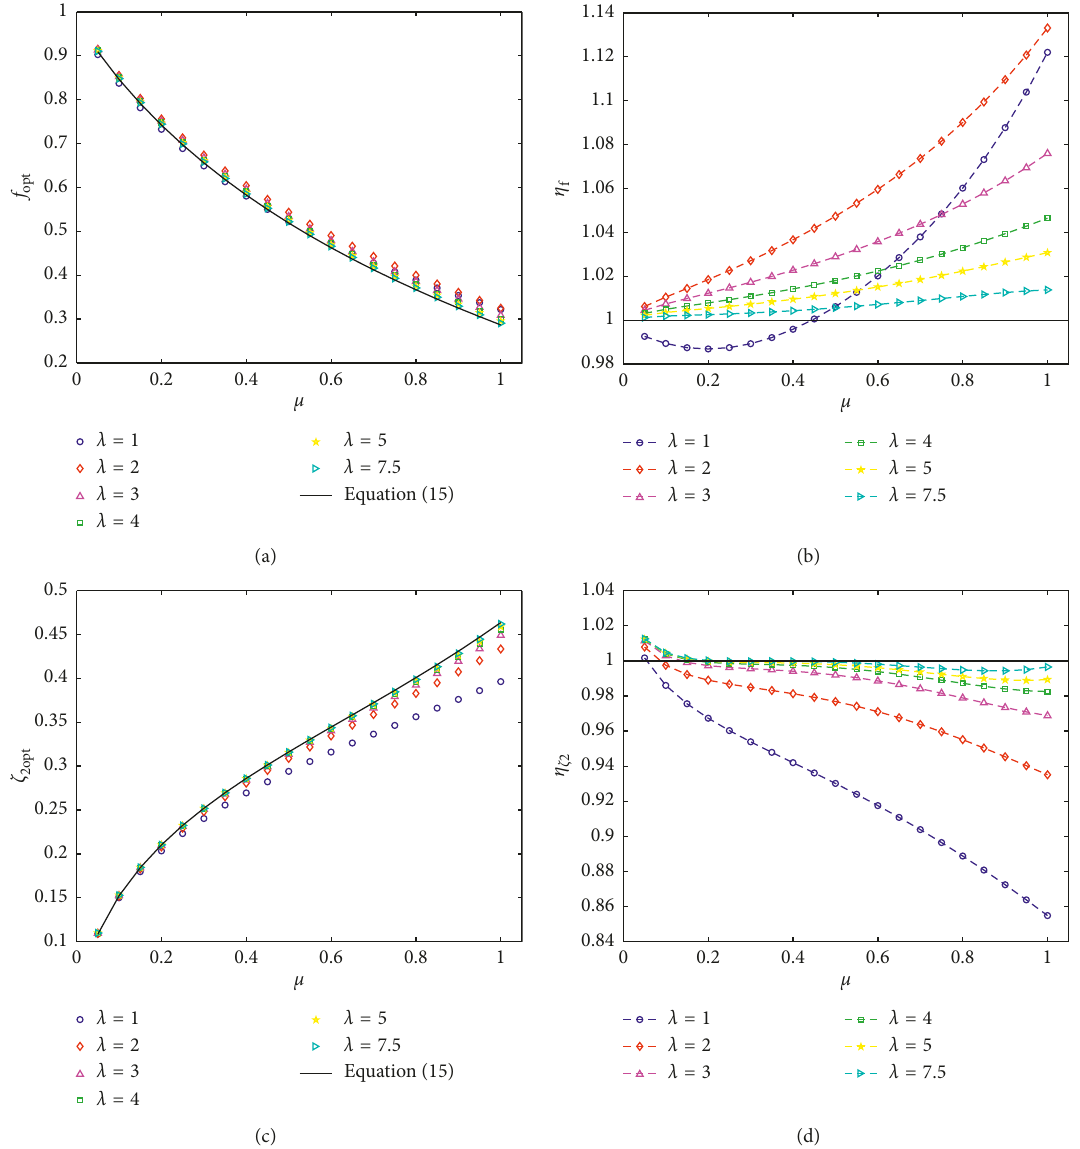
Figure 10: The relation between optimal parameters with λ and μ and its deviation rate with equation (15) under filtered white noise excitations. (a) Optimal frequency ratio. (b) η f . (c) Optimal damping ratio. (d) η ζ